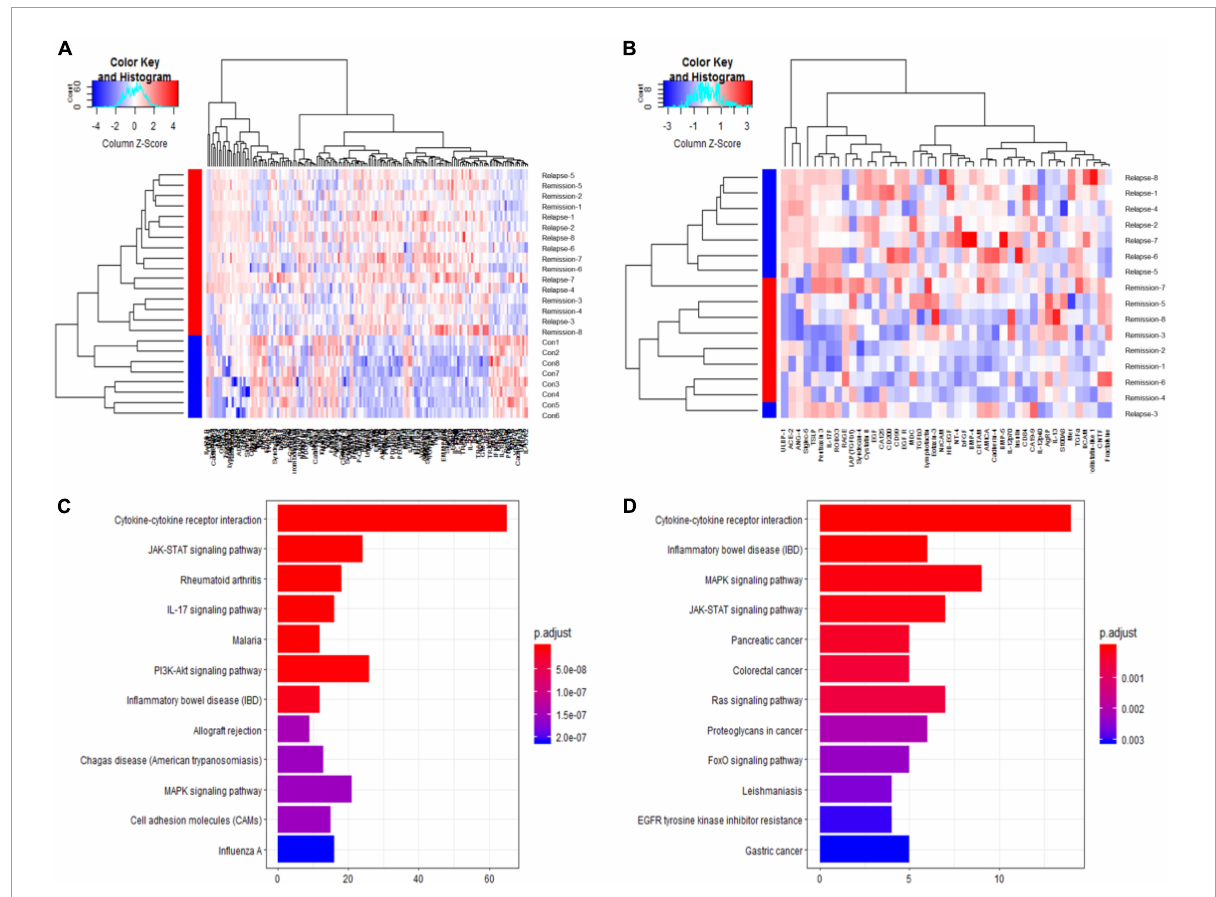
FIGURE1 Raybiotech 440 cytokine antibody microarray results. The heat map analysis (A,B) revealed that cytokines could distinguish between minimal change disease (MCD) and healthy controls and had different expression patterns between non-relapsed MCD and relapsed MCD. The red and blue colors in the heat map depict higher and lower gene expressions, respectively. The color intensity indicates the magnitude of the expression differences. A fold change of 1.2 and an adjusted P -value of 0.05 were used as the screening criteria (A) . The differentially expressed proteins screened by P -adjust were too few, so the P -value was used as the screening criteria (B) . (C) Shows the Kyoto Encyclopedia of Genes and Genomes (KEGG) pathway analysis for differential expression proteins between MCD and healthy controls. (D) Shows the KEGG pathway analysis for differentially expressed proteins between non-relapse MCD and relapse MCD patients. The analysis showed the 12 most enriched pathways with the smallest adjusted P